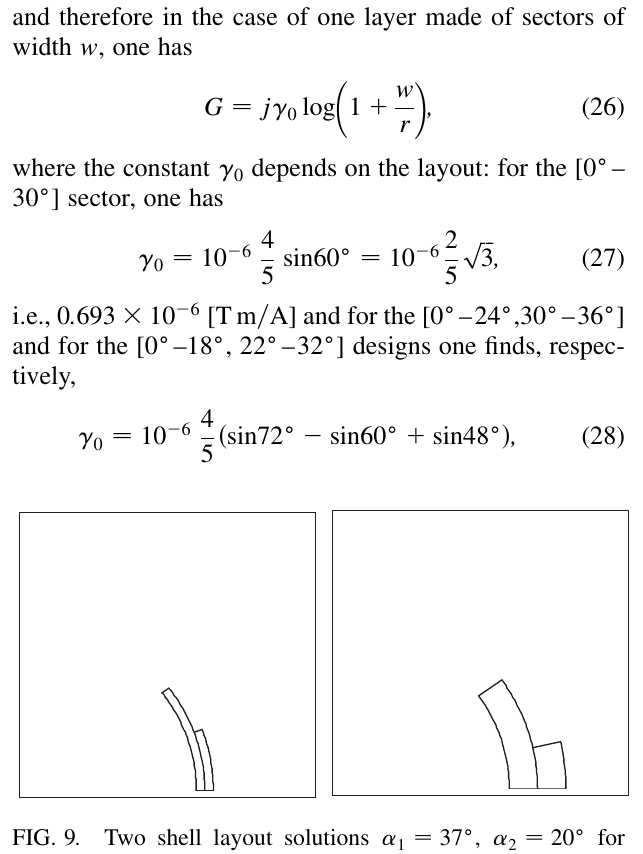
7. Two-sector layouts (one eight shown in the plot) [0 (cid:9) – 24 (cid:9) ,30 (cid:9) –36 (cid:9) ] (left) and [0 (cid:9) –18 (cid:9) ,22 (cid:9) –32 (cid:9) ] (right) that set b (cid:2) 0 and b 10